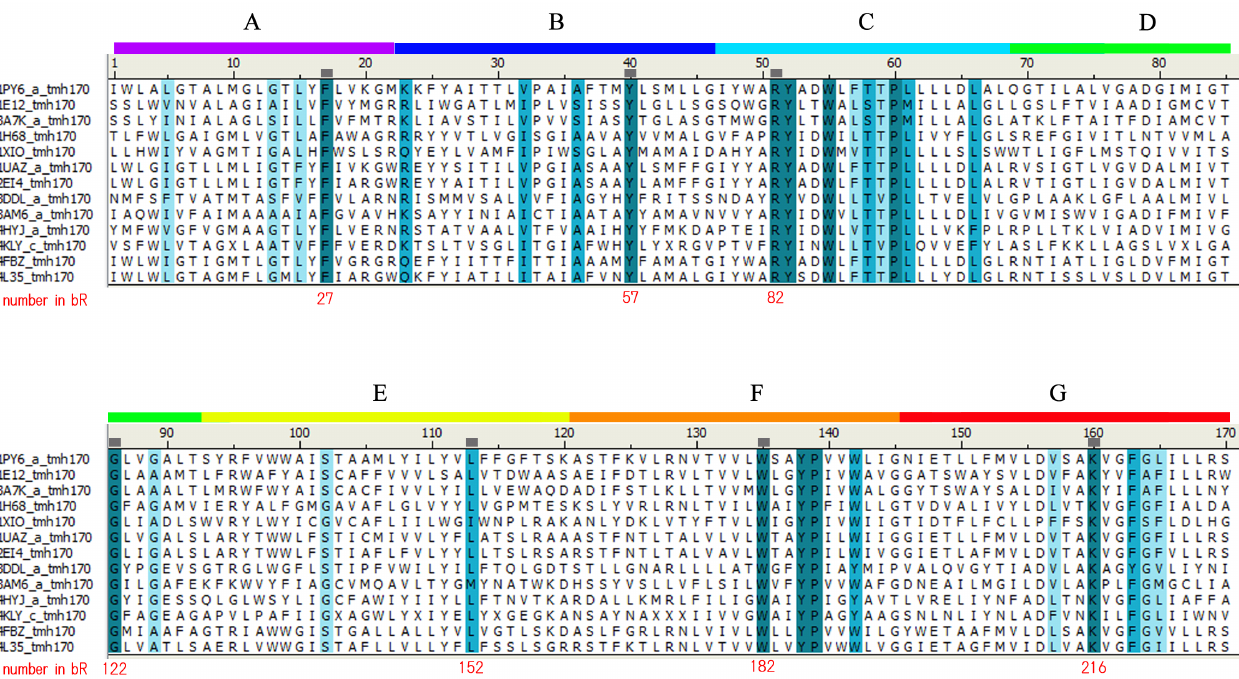
Figure S2. Sequence alignment of the 7TM regions of 13 MRs in set 3. The conserved positions are colored as follows: dark blue, identical; blue, strong similarity; light blue, weak similarity, according to PAM250 matrix definition. The small squares on the ruler indicate the *.50 positions of the numbering proposed for